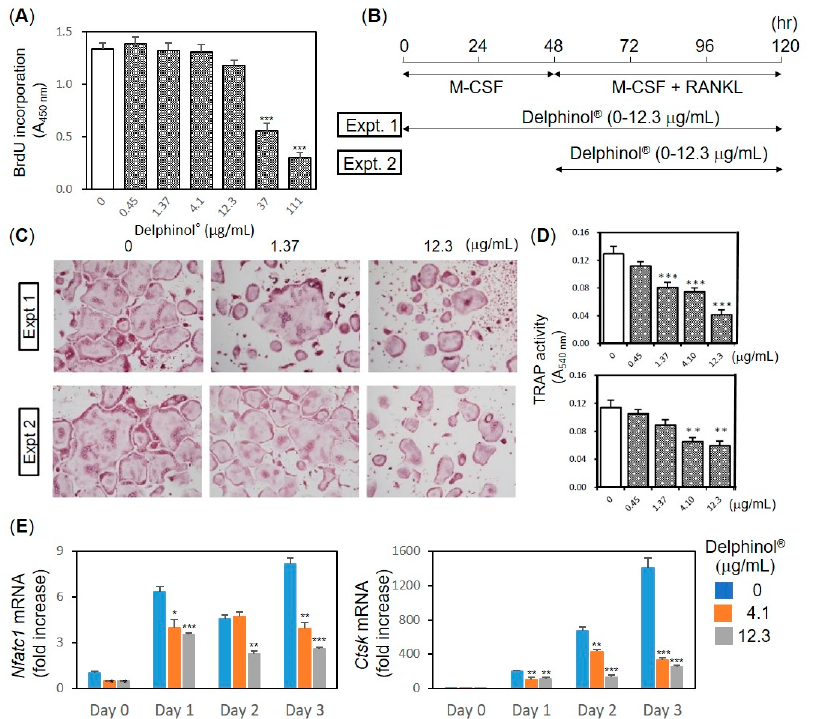
Figure 3. Effects of Delphinol ® on in vitro osteoclastogenesis. ( A ) Cell proliferation of BMM was examined by BrdU incorporation assay. Bone marrow cells (3 × 10 5 cells per cm 2 ) were cultured in α -MEM containing 10% FBS supplemented with 4000 U of Leukoprol for 2 days and incubated tartrate-resistant acid phosphatase (TRAP) staining in osteoclasts (OC) cultures. Scale bars = 50 µ